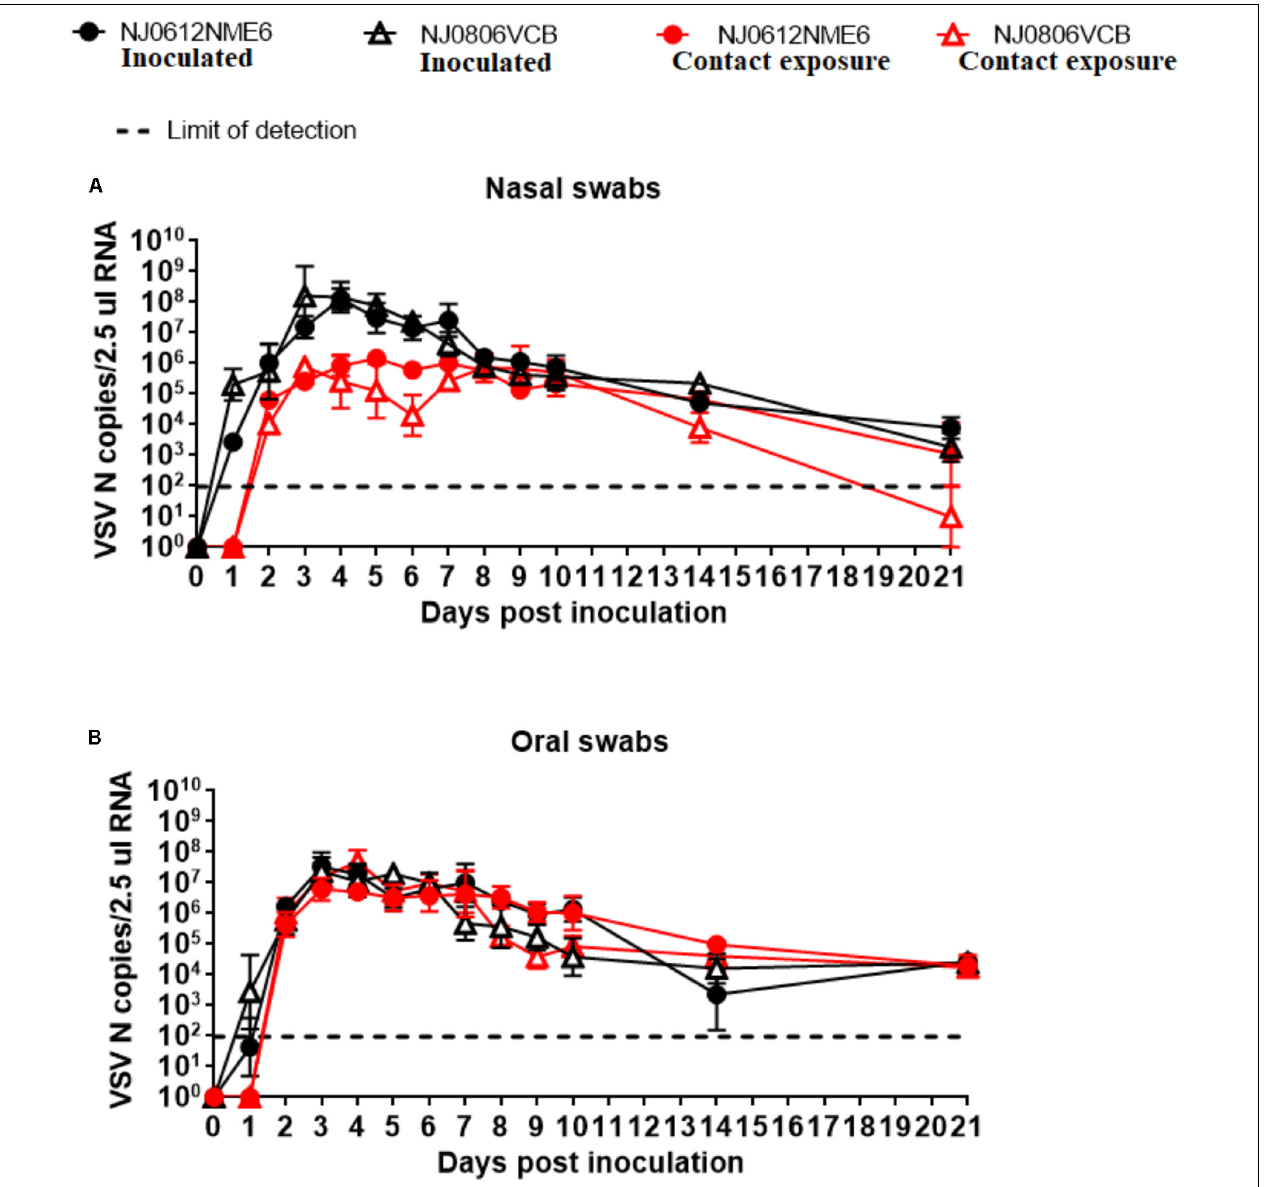
FIGURE 8 | Detection of viral RNA in clinical samples. Biological samples were collected at indicated time points after inoculation with NJ0612NME6 or NJ0806VCB and RNA was analyzed by rRT-PCR to detect VSV nucleocapsid (N) RNA in (A) nasal swabs or (B) oral swabs of both directly inoculated and contact exposure